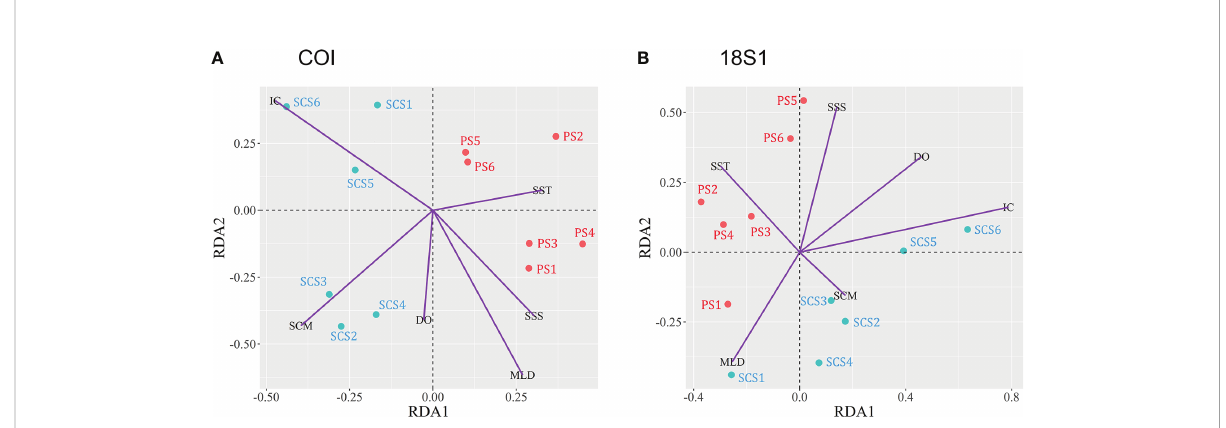
FIGURE 6 RDA ordinations showing the meroplankton composition in relation to environmental variable. (A) COI; (B) 18S1. SST, surface seawater temperature; SSS, surface seawater salinity; DO, dissolved oxygen; MLD, mixed layer depth; DCM, deep chlorophyll maximum; SCM, Subsurface chlorophyll maximum; IC, integrated chlorophyll of the upper 200m water column.